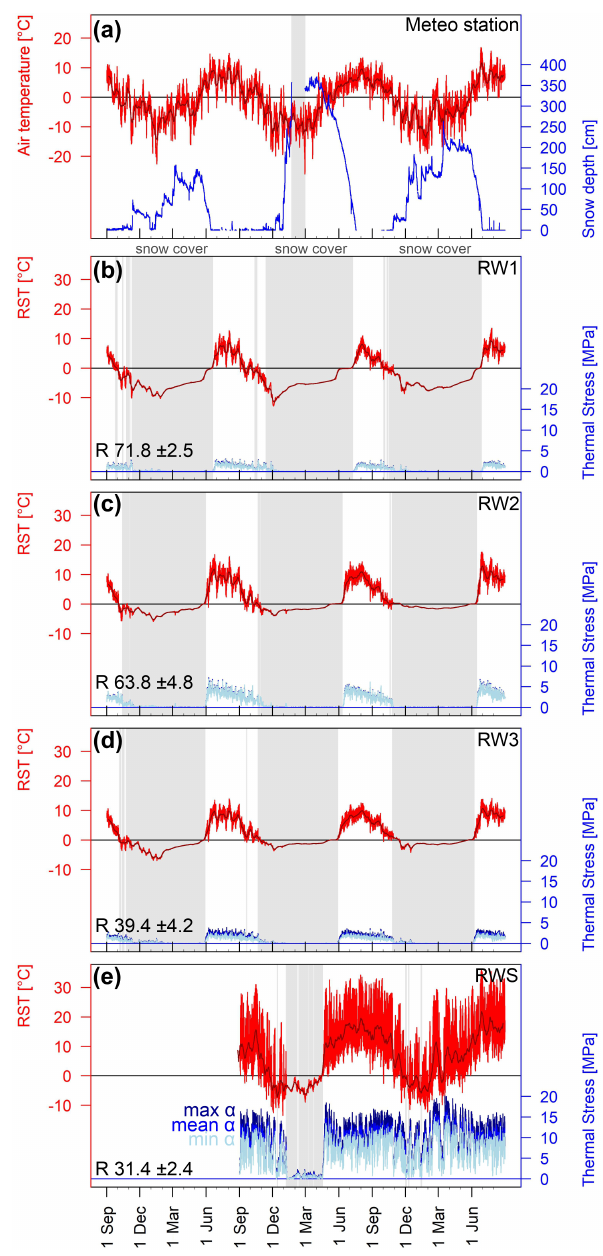
Figure 4. (a) Air temperature and snow depth from meteo station Oberer Stelligletscher plotted for the period from September 2016 to August 2019. Rock surface temperatures (red lines) and mean 10d RST (dark red line) recorded by iButtons installed at (b) RW1, (c) RW2, (d) RW3 and (e) RWS. Thermal stress was modelled using minimum α (light blue lines), mean α (blue lines) and maximum α (dark blue lines). Grey rectangles highlight the data gap filled with modelled air temperatures in (a) and snow cover (b–e) . Numbers represent measured Schmidt hammer rebound values R